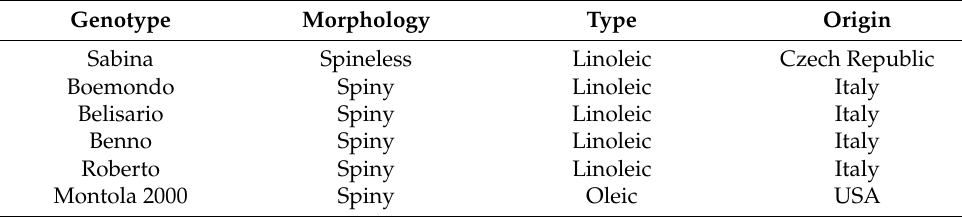
Table 1. Main characteristics of safflower genotypes used in the study. Genotype Morphology Type Origin Sabina Spineless